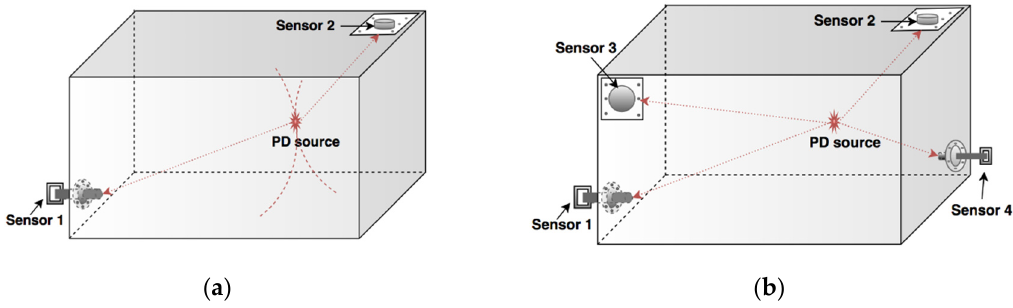
Figure 9. UHF sensor arrangement for PD localization ( a ) with two sensors ( b ) with four